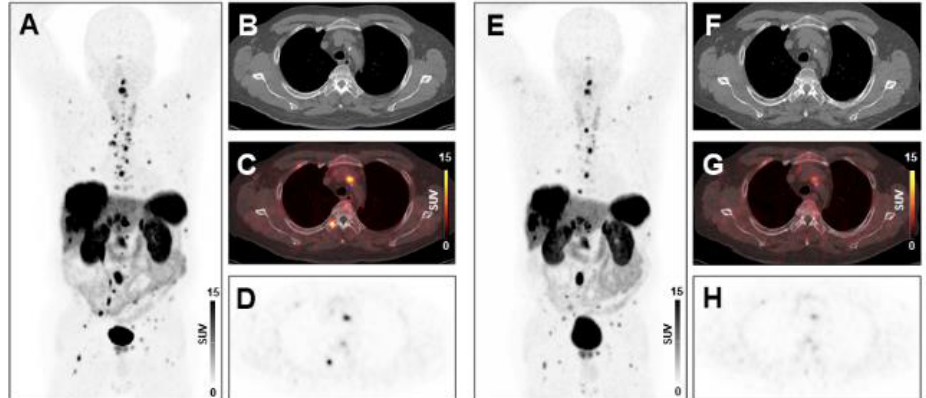
Figure 2. Treatment response to peptide receptor radionuclide therapy (PRRT) in a patient with low systemic inflamma- tion at baseline. Maximum-intensity-projection (MIP) image ( A ) and transversal PET/CT images ( B – D ) of baseline [ 68 Ga]Ga-DOTA-TATE PET/CT showing osseous, hepatic, and lymph node metastases in a 66-years-old male gastro-en- tero-pancreatic neuroendocrine tumor (GEP-NET) patient. MIP image ( E ) and transversal PET/CT images ( F – H ) at fol- low-up after two cycles of PRRT demonstrating decreasing tracer uptake or disappearance of lesions (SSR-TV decreased from 496 cm 3 to 277 cm 3 , consistent with stable disease). The baseline CRP level was 1.6 mg/L, ANC was 4.0 × 10 9 /L, the PCM was 227.2, and the HSPI was 0, evidencing low systemic inflammation.